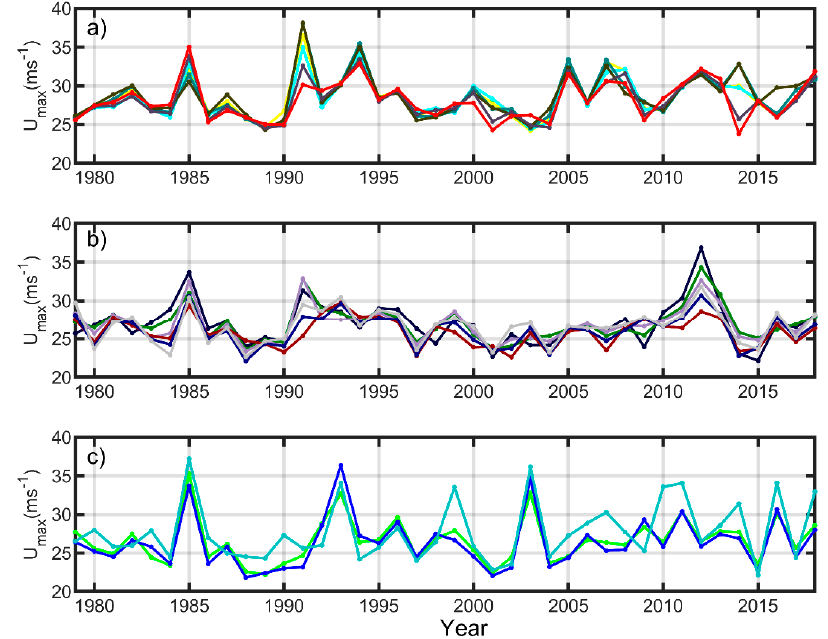
Figure 2. Time series of annual maximum wind speeds for the LA shown in Figure 1. ( a ) northern group of LA (1–7) off the coast of MA/RI, ( b ) mid LA 8–13 off the coasts of NY, NJ, DE and MD and ( c ) south LA 14–16 off the coast of VA and NC. The color coding for the LA is shown in Figure 1.